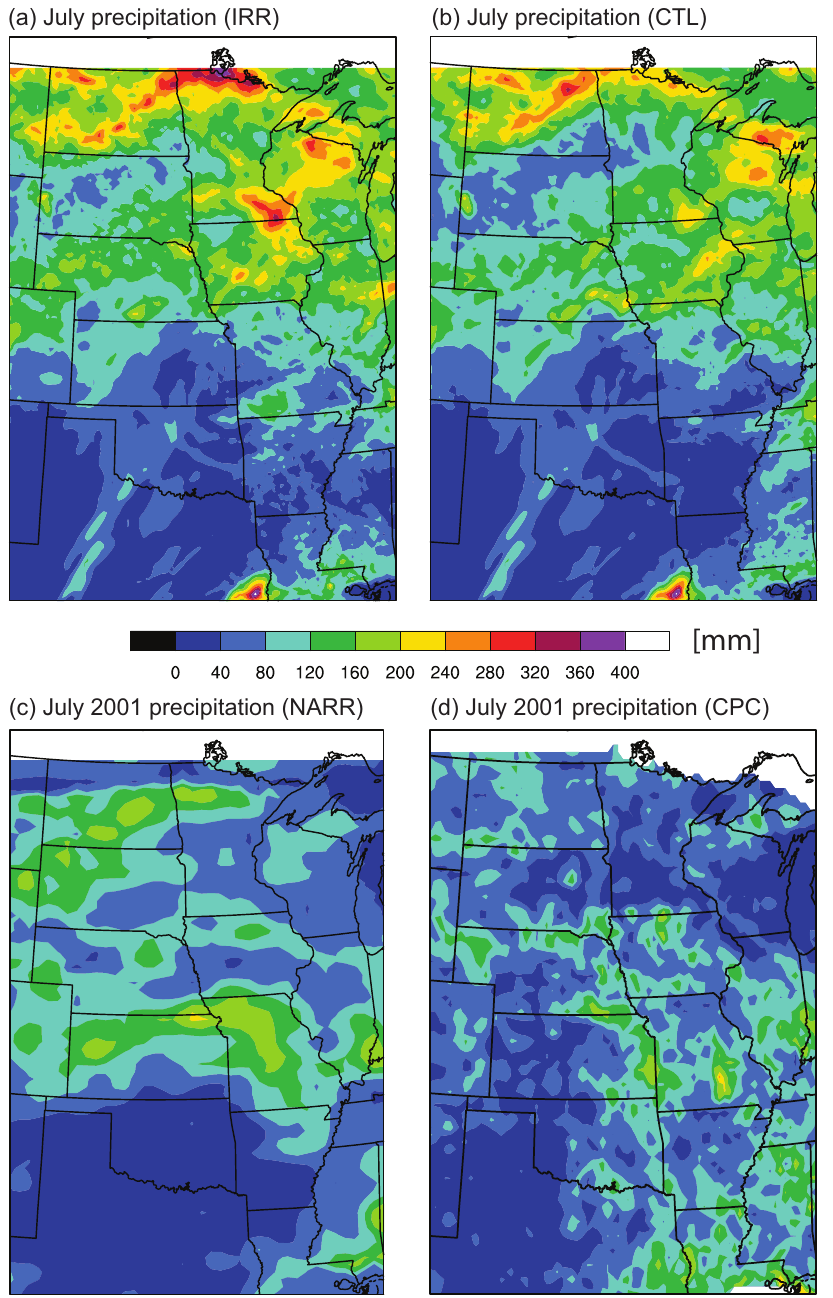
Figure 2. Accumulated precipitation for the month of July for the ( a ) IRR and ( b ) CTL simulations, respectively; ( c ) July 2001 precipitation from the North American Regional Reanalysis (NARR); ( d ) July 2001 precipitation from the CPC U.S. Unified Precipiation